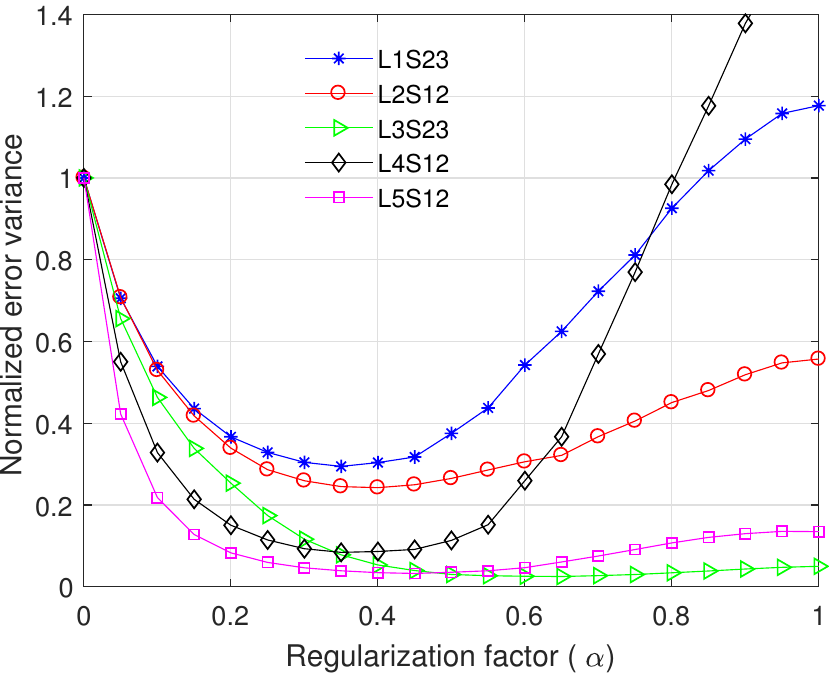
Figure 10. Normalised variance of time difference error as a function of α , when measured coherence values were used, N = 4096, M = 25, and σ 2 e =